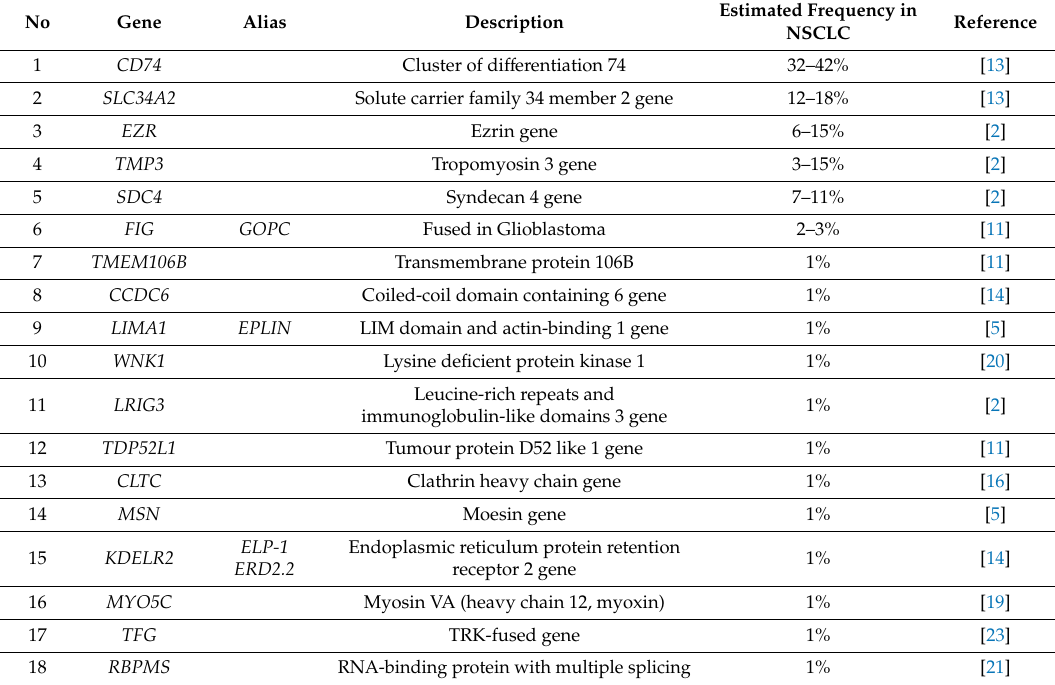
Table 1. Main ROS1 fusion partners in non-small cell lung cancer